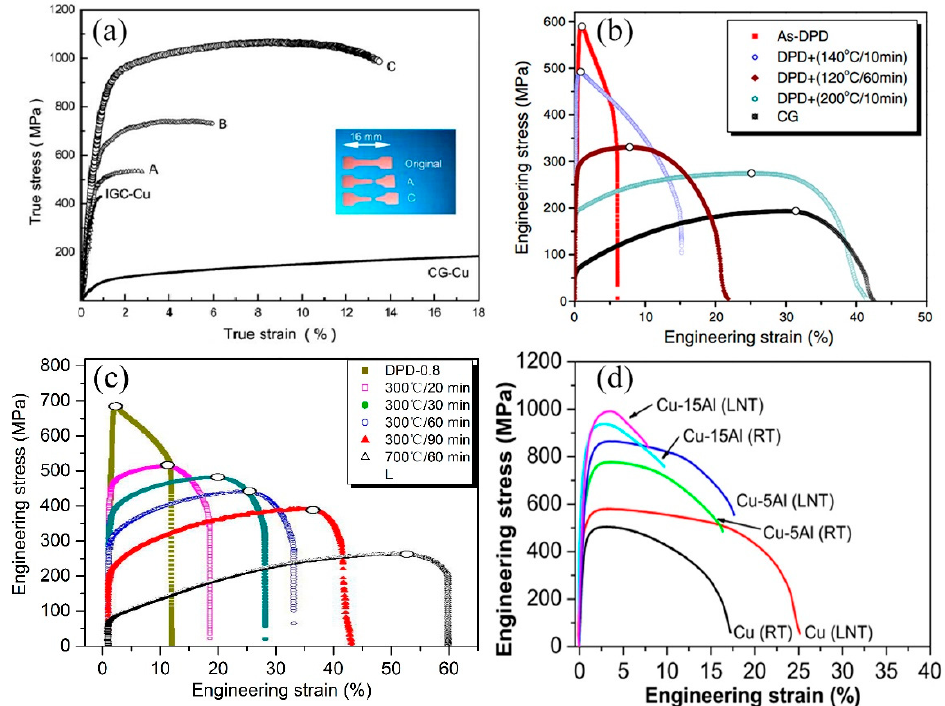
Figure 12. Typical tensile strain-stress curves. ( a ) as deposited Cu (adapted from Refs. [75]); ( b ) DPD-Cu (adapted from Refs. [90]); ( c ) DPD-Cu-Zn (adapted from Refs. [80]); ( d ) Cu-Al (adapted from [91]).